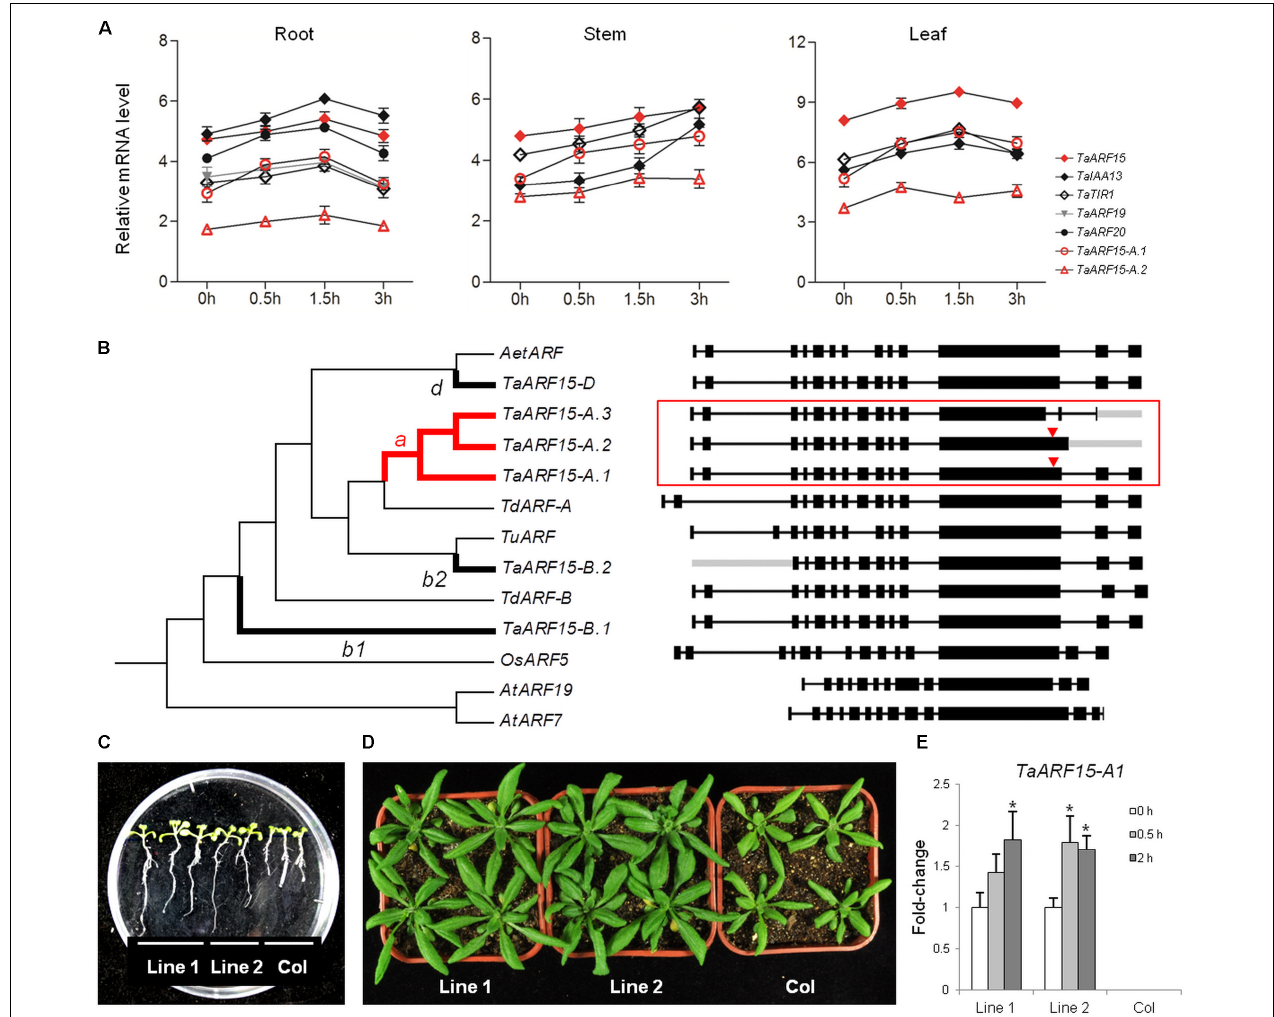
FIGURE 5 | Co-expression, evolutionary, and functional analysis of TaARF15. (A) Auxin-related genes expressed simultaneously with TaARF15 in the roots, stems, and leaves of wheat cultivar “Chinese Spring” at the seedling stage. The qRT-PCR data were processed by the 2 - (cid:49)(cid:49) C t method, and GADPH served as the control. (B) Phylogenetic analyses of the six transcribed sequences of TaARF15 as well as those of its homologs in T. urartu ( TuARF , TRIUR3_19224), Aegilops speltoides ( AetARF , AEGTA09095), T. dicoccoides ( TdARF-A , TRIDC6AG014880.2; TdARF-B , TRIDC6BG020370.14), and rice ( OsARF5 , Os02g04810); AtARF7 (AT5G20730.3) and AtARF19 (AT1G19220.1) served as out branches. The exon/intron structures are listed on the right. The branches with TaARF15-A , B , and D are shown as thick lines and labeled with letters a, b1/b2, or c, respectively, and the ω values were calculated in accordance with the two-ratio model. The branch that underwent positive selection is labeled in red, and the positive selection sites of sequences are marked with red triangles. (C,D) Morphology of the roots and leaves of 35S:: TaARF15-A.1 lines and Col, the latter of which represents wild-type Arabidopsis plants. (E) Relative expression levels of TaARF15-A.1 in both Col and homozygous F 3 transgenic lines. The total RNA was isolated from 20-day-old leaves of Arabidopsis plants at 0, 0.5, and 2 h after 10 µ M auxin solution treatment. ACTIN2 served as an endogenous